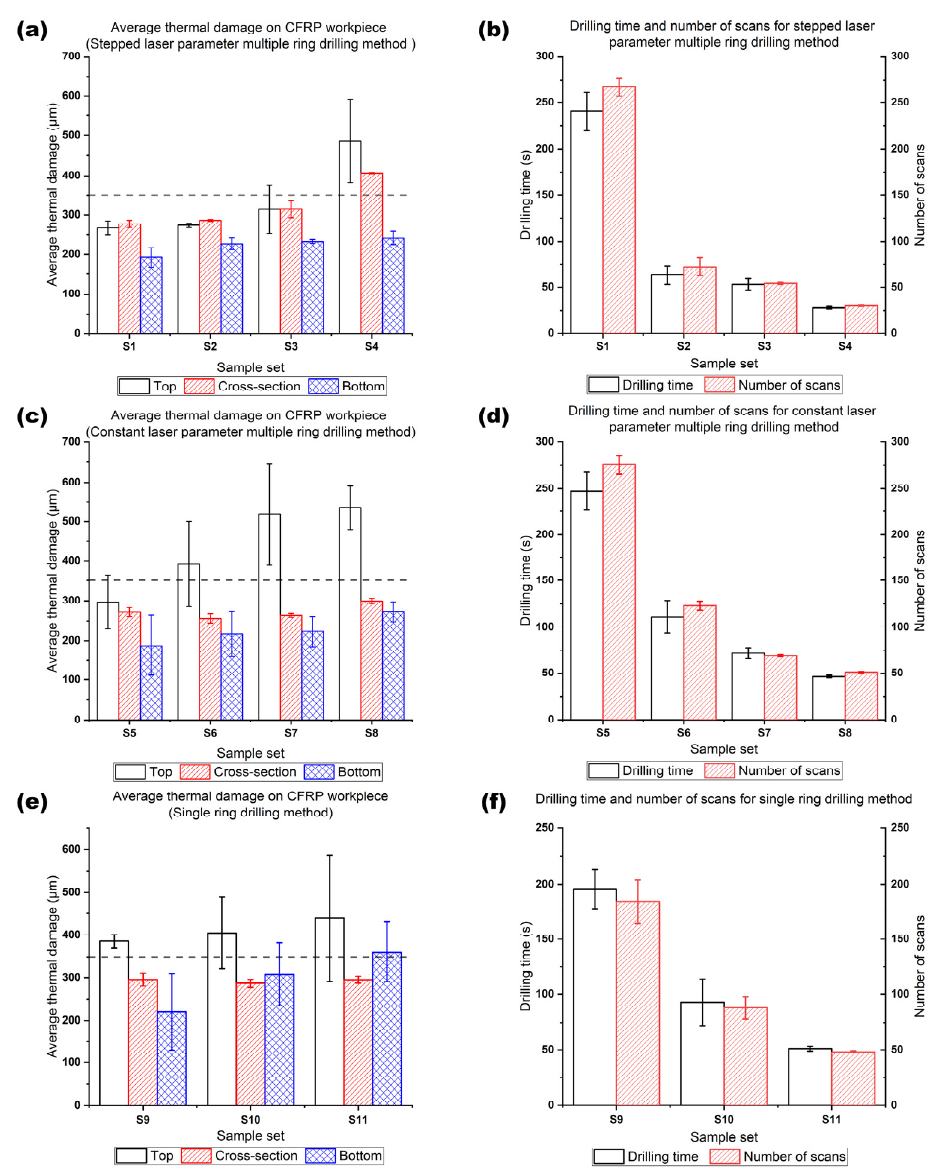
Figure 8. Comparison of average thermal damage via stepped laser parameter multiple-ring drilling method, constant laser parameter multiple-ring drilling method, and single-ring drilling method.